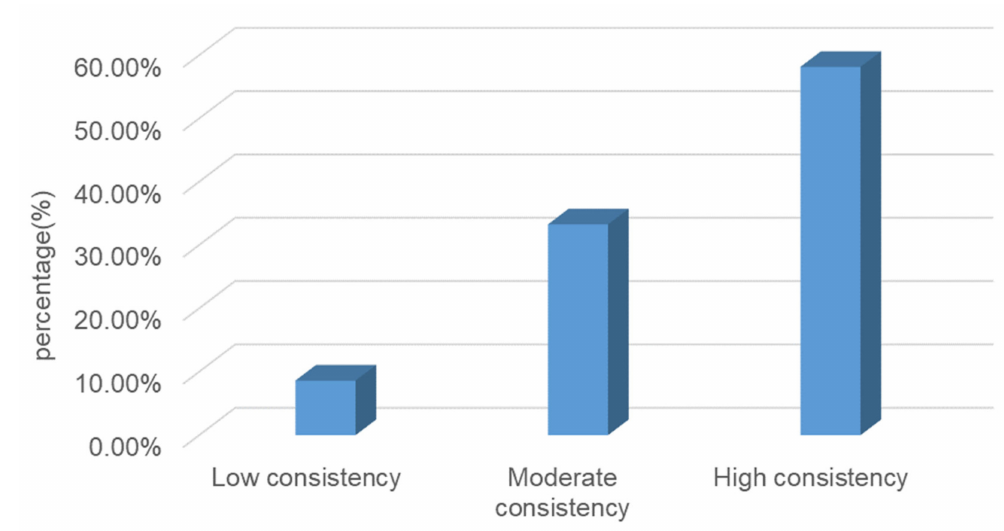
Figure 9. Consistency area percentage of all land cover types in the study